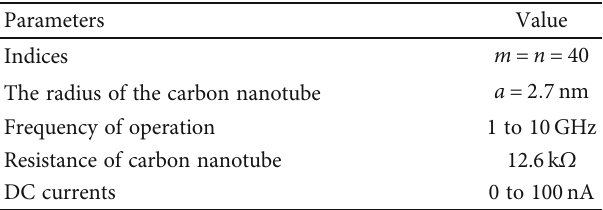
Figure 7: Two transmission line models of carbon nanotube antennas. Table 2: Simulation